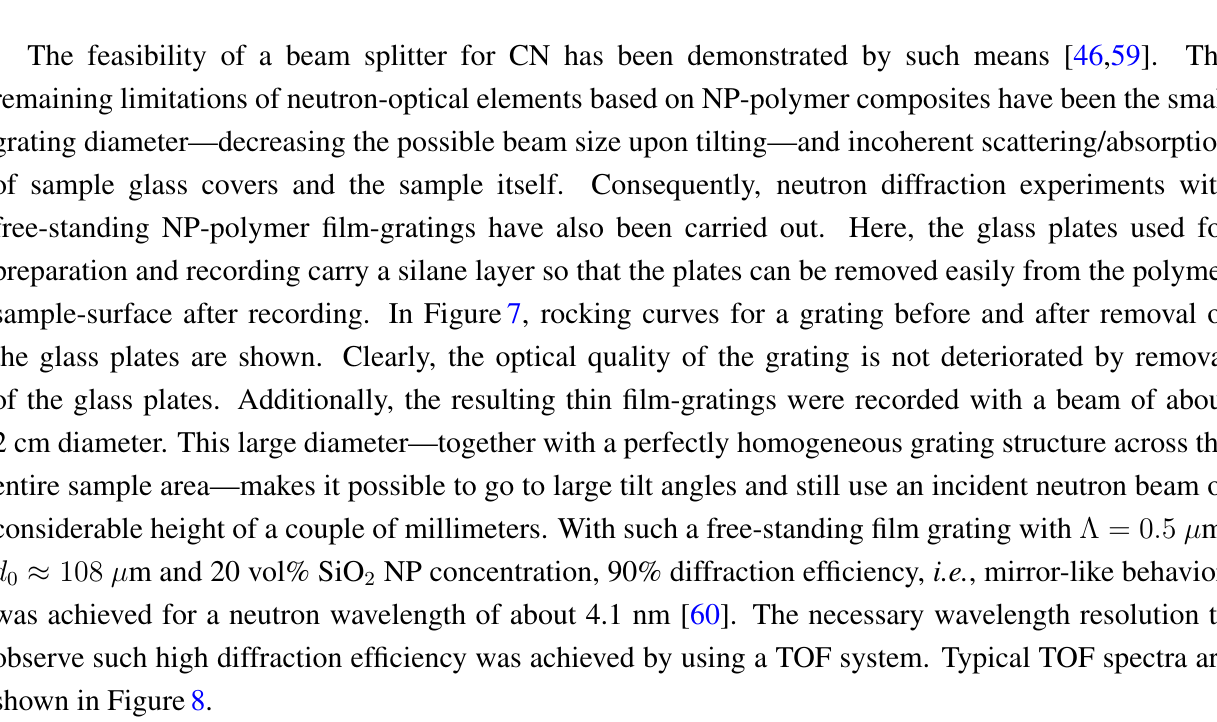
▽ · · · + 1 st ≈ 115 µ m, 20 vol% SiO NPs. The slight shift 0 2 is due to the broad incident P